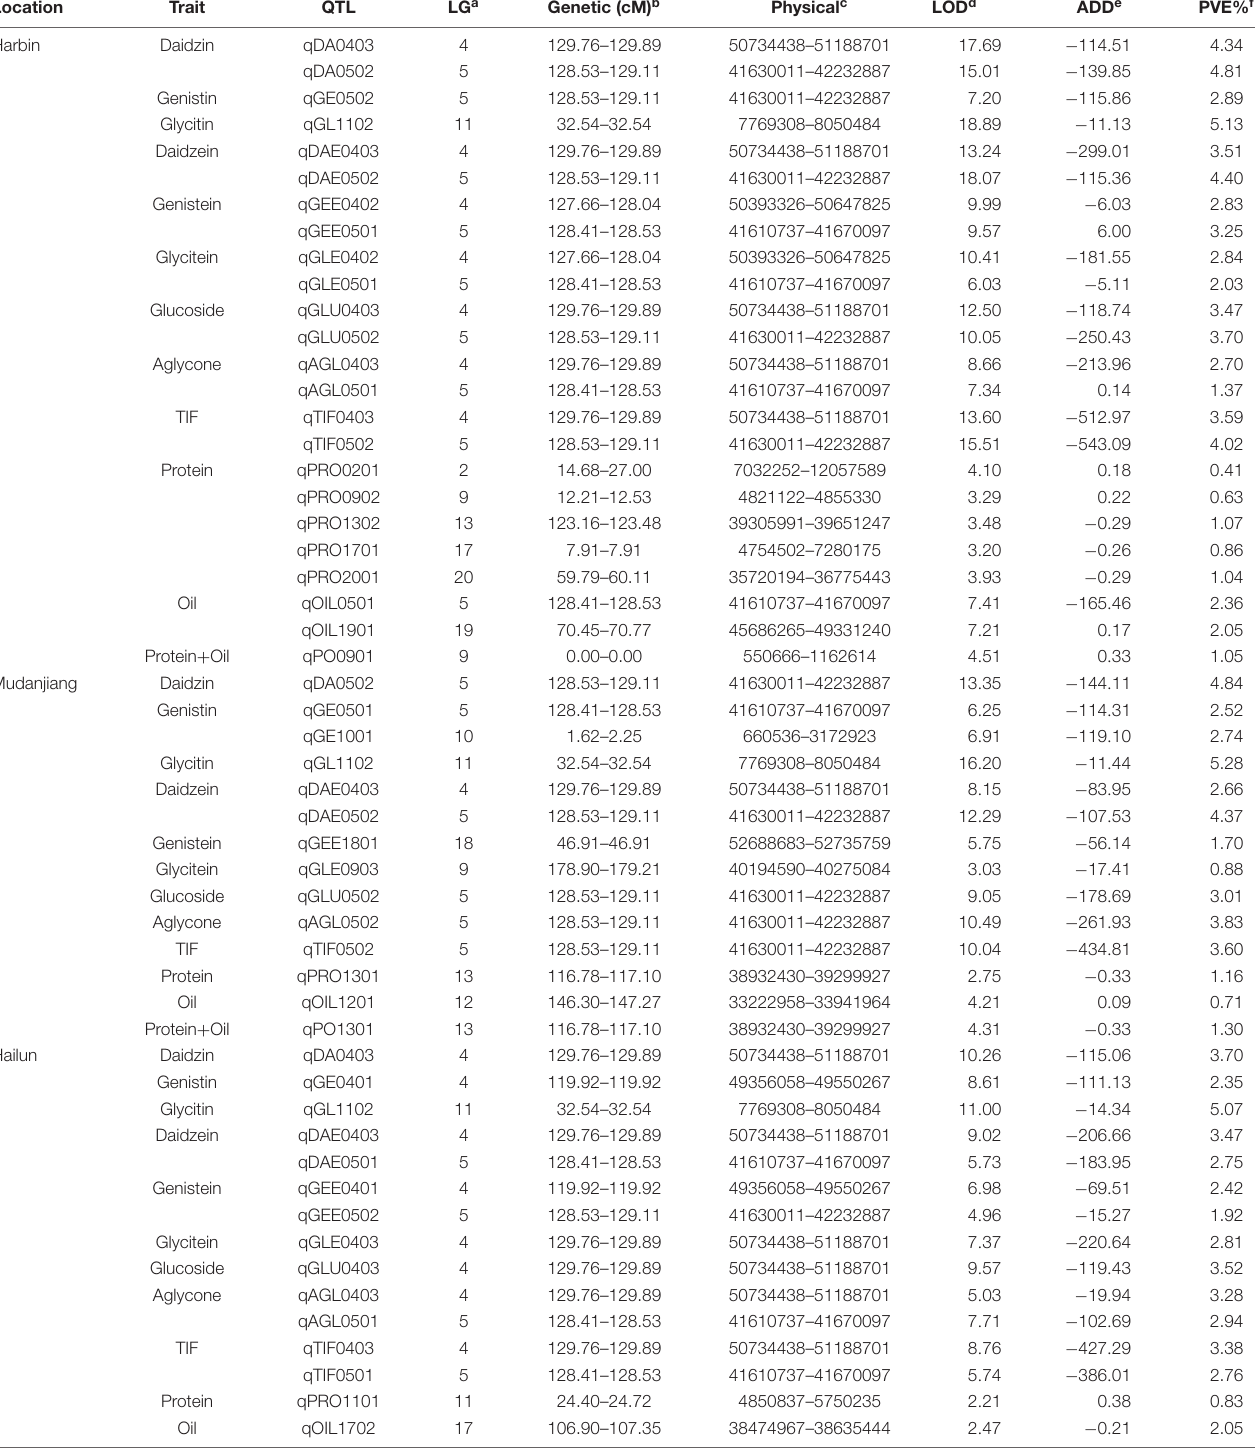
TABLE 5 | QTL mapping of 12 quality traits for the ZH RIL populations in the three experimental locations.